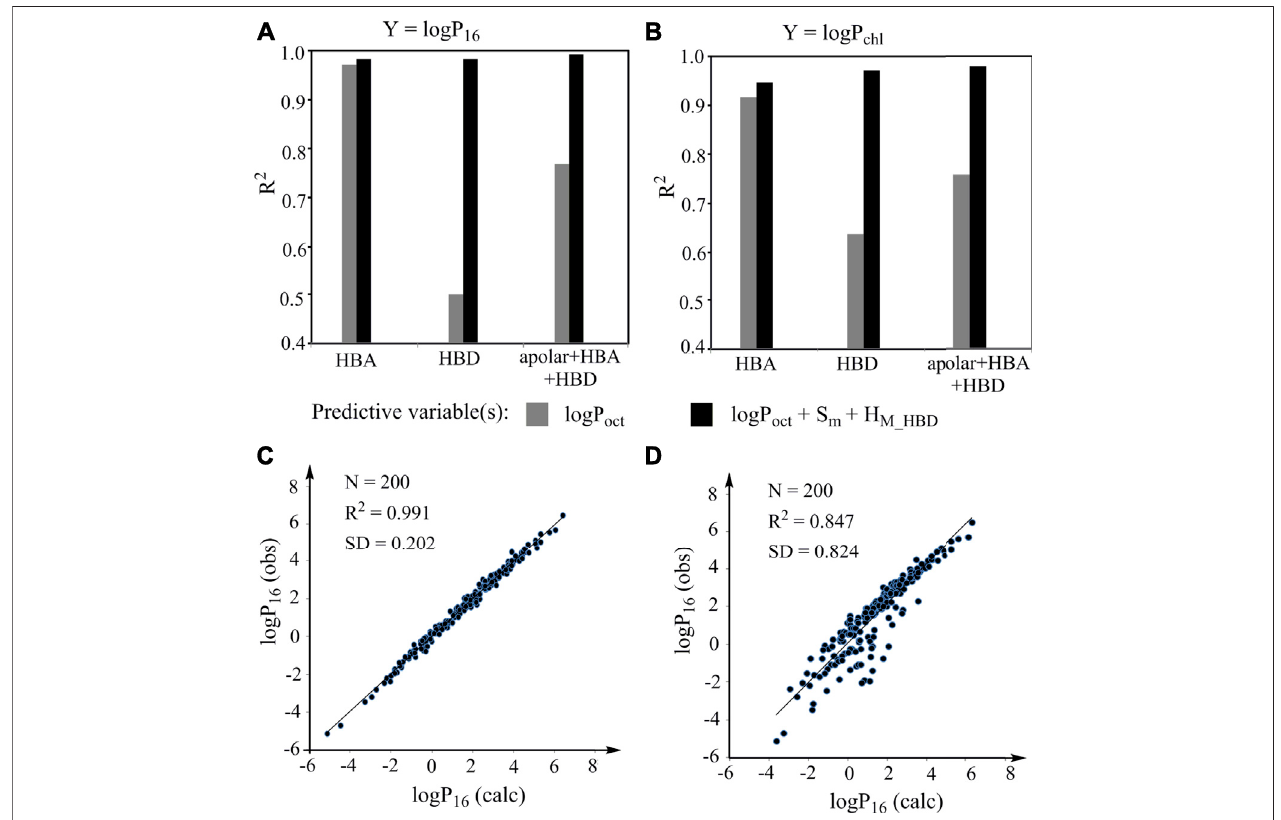
FIGURE 3 | Prediction of organic solvent/water partition coef fi cients for validating the general LFER. (A, B) R 2 values of the simple regressions (gray columns) of logP 16 (A)/logP chl (B) against logP oct and of the corresponding models constructed according to the LFER (black columns). HBA: compounds containing HBAs but no HBDs; HBD: compounds containing HBDs; apolar: nonpolar compounds; (C) Plot of observed logP 16 against the logP 16 calculated from the model constructed according to the LFER; (D) Plot of observed logP 16 against the logP 16 calculated from the model with logP oct as predictive valuable.